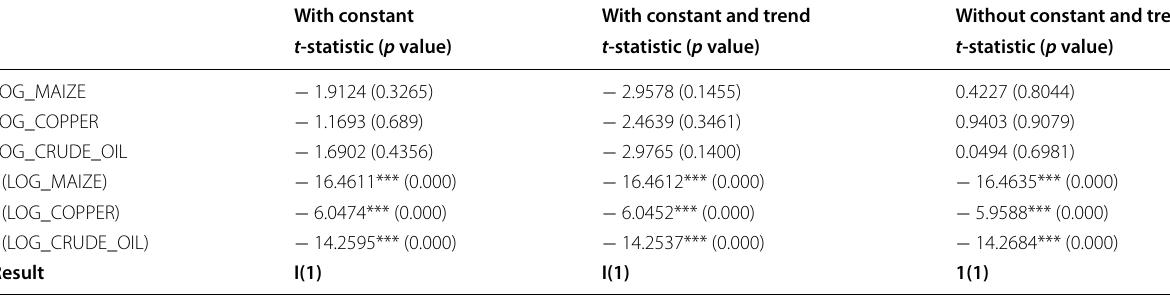
(***) Significant at the 1% and t value without ***not significant, b: lag length based on AIC, probability based on MacKinnon [25] one-sided p values. I(1) Integrated of order 1